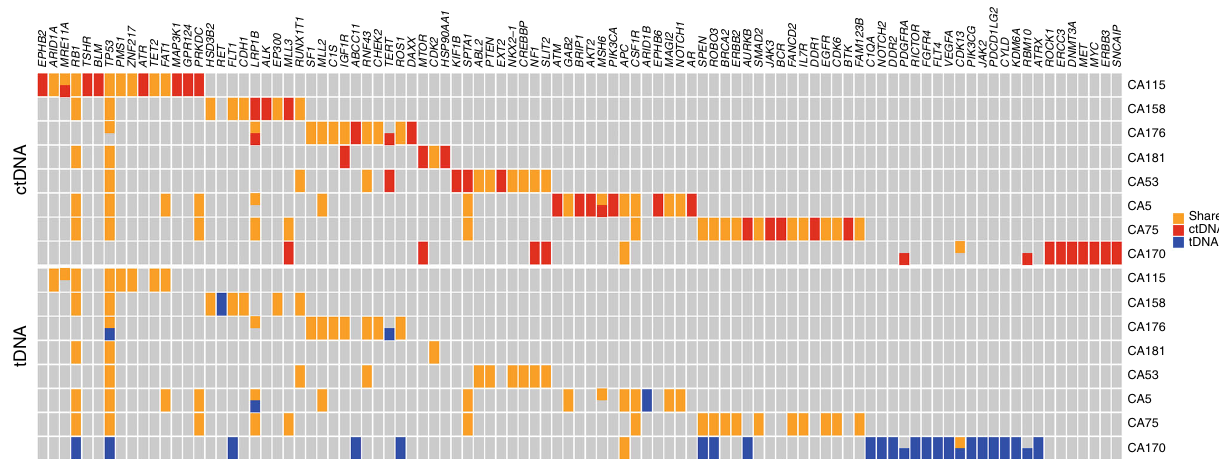
Fig. 2 Somatic mutations detected in paired tumor DNA and ctDNA. Genes with somatic mutations were listed on the x -axis, and samples were shown on the y -axis. Mutations detected only in tumor DNA (tDNA), only in ctDNA or in both were shown in blue, red and orange, respectively